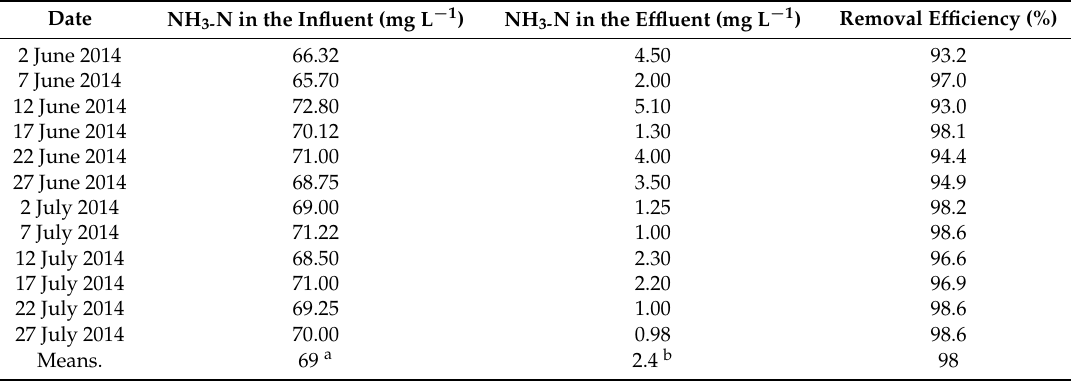
Efficiency of a trickling filter in removing ammonia nitrogen from an anaerobic digester effluent.